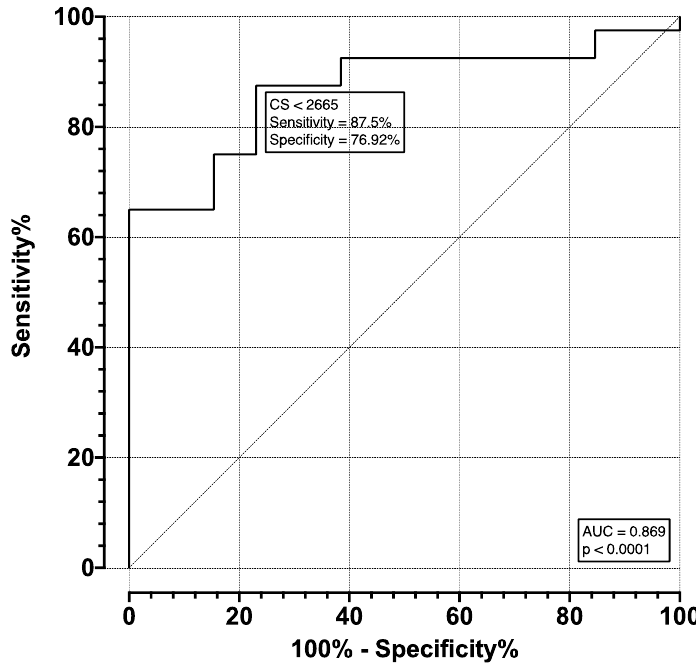
Figure 5. ROC for detection of severe AS .